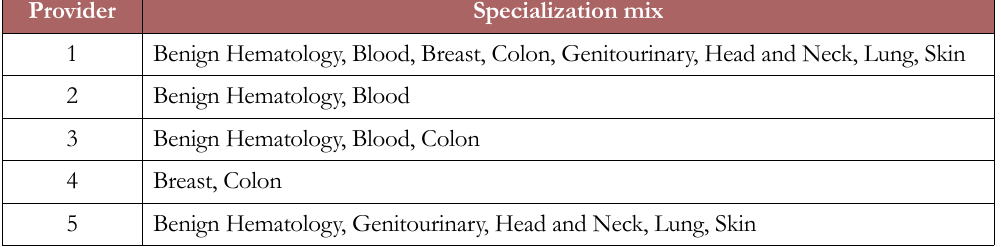
Table 2. Oncologists’ current specialization